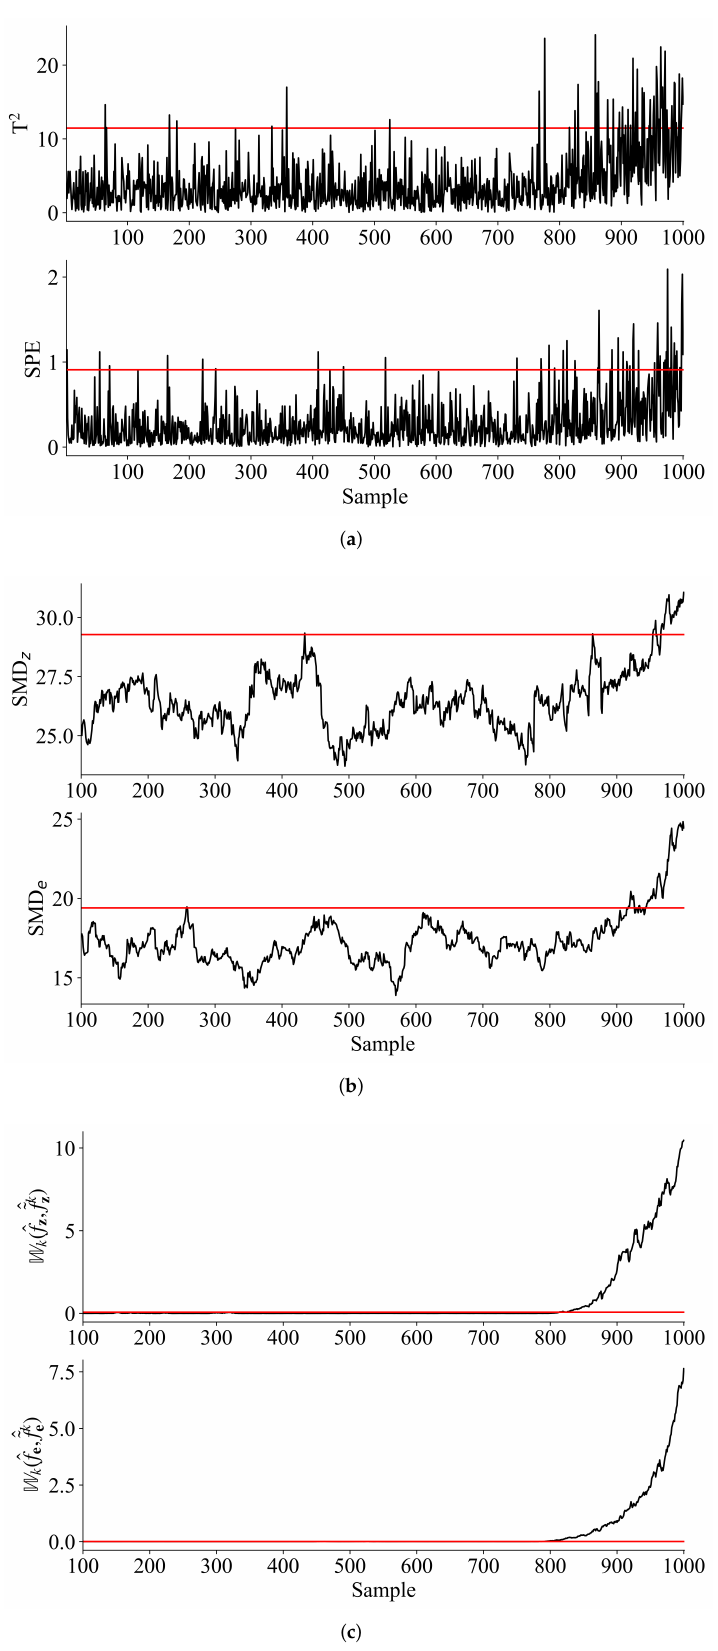
Figure 2. Monitoring results for the simulation example: ( a ) PCA ( b ) SMD ( c ) Wasserstein